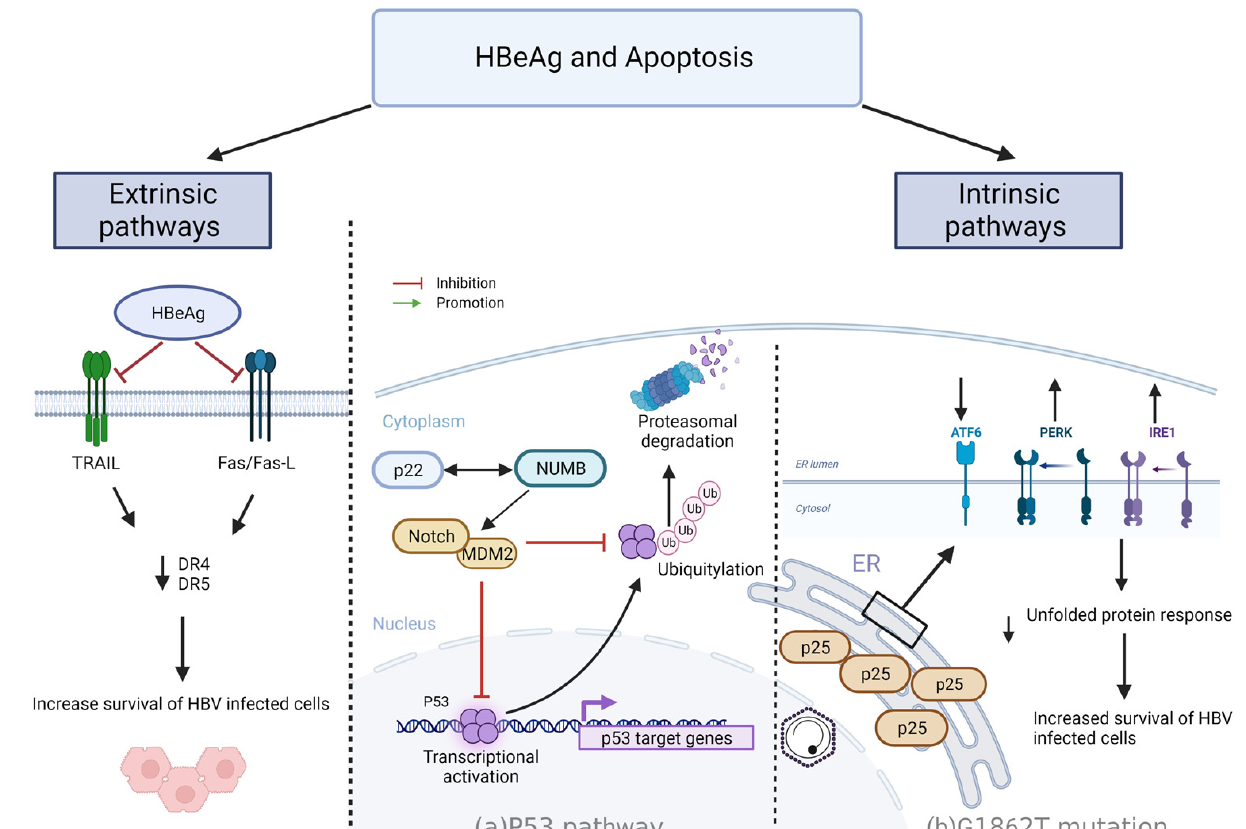
Figure 4. The role of HBeAg in Apoptosis: the role of HBeAg and its precursors in extrinsic and intrinsic apoptotic pathways. Extrinsic pathway: HBeAg inhibits Fas/FasL and TRAIL/DR systems which leads to the down-regulation of Fas death receptors, DR4 and DR5, expression to promote the survival of HBV infected hepatocytes [148]. Intrinsic pathways: ( a ) P53 pathway—p22 interacts with NUMB, which regulates Notch and MDM2 preventing ubiquitination and degradation of p53 and impairing the stability and transcriptional activity of p53 [128]; ( b ) G1862T mutation—G1862T mutation results in the accumulation of p25 in the ER, decreasing the activity of the PERK and IRE1/XBP1 while increasing the activity of the ATF6 receptor pathways. This results in a decrease in UPR to promote survival of HBV infected hepatocytes [122]. Image created using biorender.com .